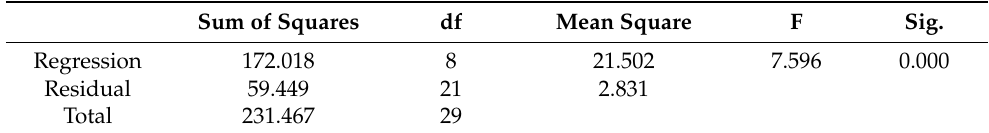
Table 14. Multiple Linear Regression result.